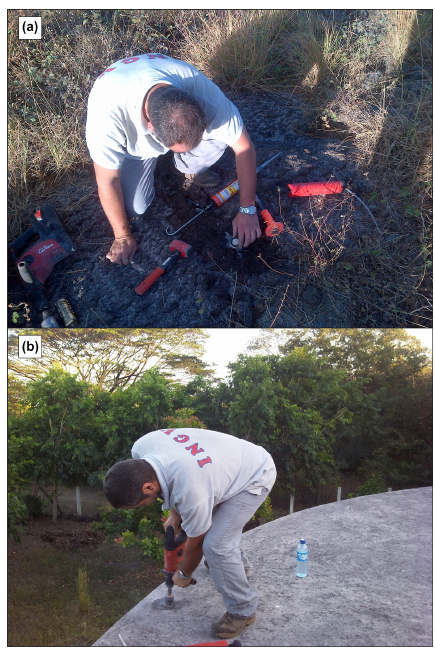
Figure A2. Installation of (a) Lacayo benchmark (LACA) on rocky lava outcrop and (b) Tanque benchmark (TANQ) on existing rein- forced concrete structure.